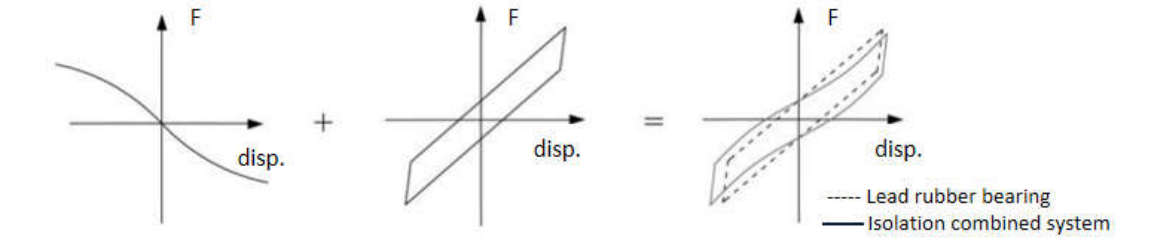
Figure 14. Mechanical model of negative-stiffness isolation system.